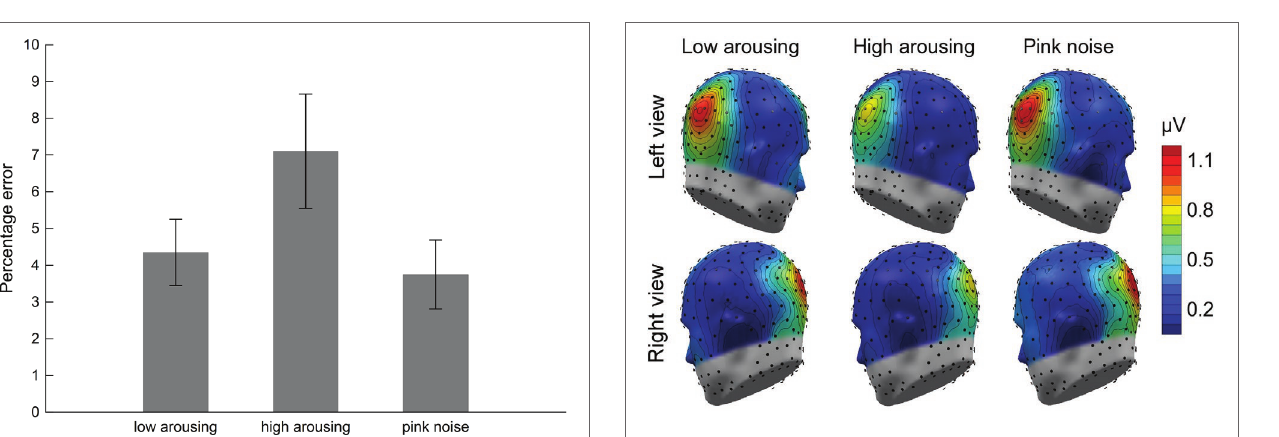
FIGURE 4 | Topographical maps: Cortical response to the math-problem triplets. Left- and right-hemisphere views of grand mean ssVEP-amplitude distribution across the scalp (spline-interpolated maps) for the study group of 20 participants. The illustration represents the mean energy across the early and late time segments (400–2,600 ms and 3,400–5,600 ms, respectively), selected to extract the ssVEP signal. Prominent ssVEP amplitudes at the expected frequency of 10 Hz occurred at occipital sites across all auditory distractor